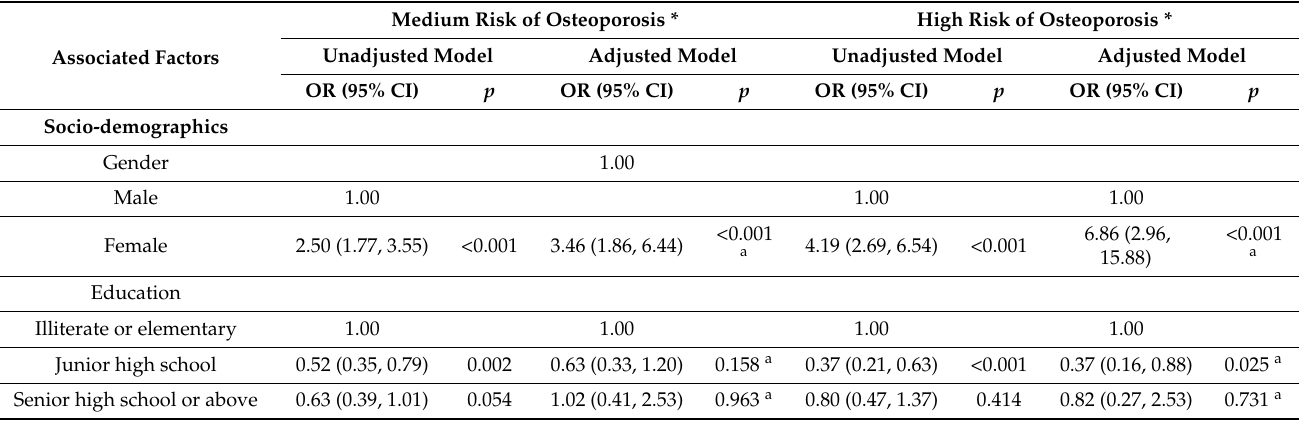
Table 2. Associated factors of osteoporosis via unadjusted and adjusted multinominal logistic regression